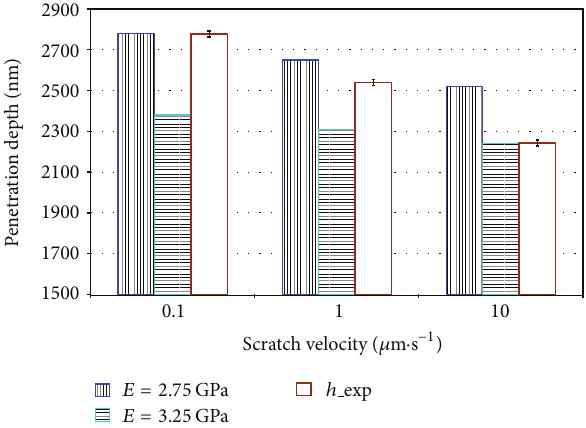
Figure 8: Comparison of experimental results ( ℎ exp) and numeri- cal results for 𝐹 𝑛 = 80 mN. The data denoted by 𝐸 = 2.75 GPa (resp., 𝐸 = 3.25 GPa) are those calculated with the elastic-viscoplastic model in using a Young modulus of 2.75 GPa (resp., 3.25 GPa).